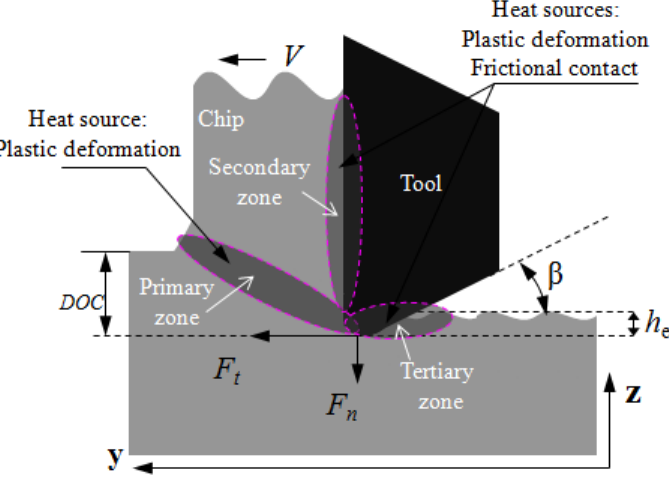
Figure 3. Three deformation zones and two interfaces in ultra-precision machining.